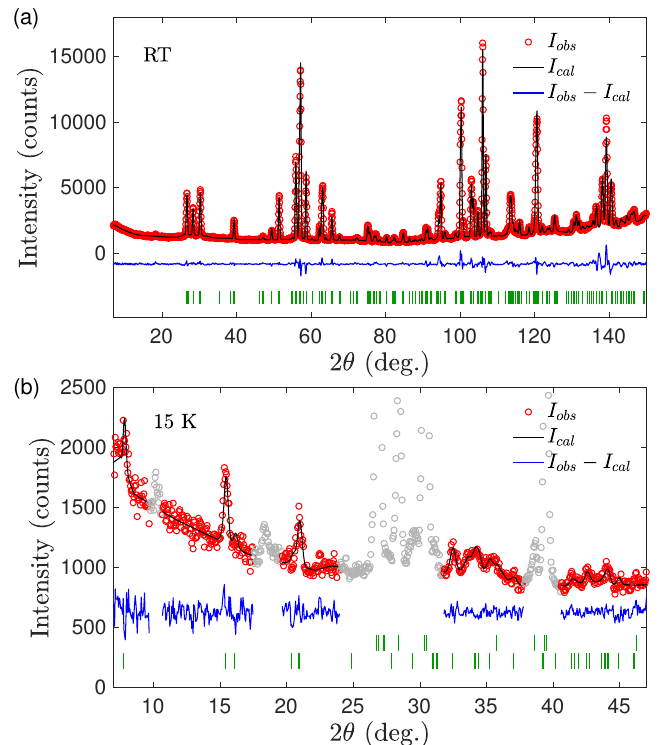
Figure 7: Observed [ (red) dots ] and calculated [ (black) solid line ] diffraction pat- terns at (a) RT and (b) 15 K with the difference curve shown (in blue) at the bottom. In (a) the (green) markers indicate the position of nuclear Bragg peaks within the P bn 2 space group. In (b) the first row of (green) markers denotes the position of 1 nuclear Bragg peaks, while the second row indicates the positions of magnetic Bragg peaks with the propagation vector q = ( 1 / 3 0 0). Gray data points show the regions which were excluded from the fit for containing either nuclear peaks or parasitic peaks also present above the magnetic ordering